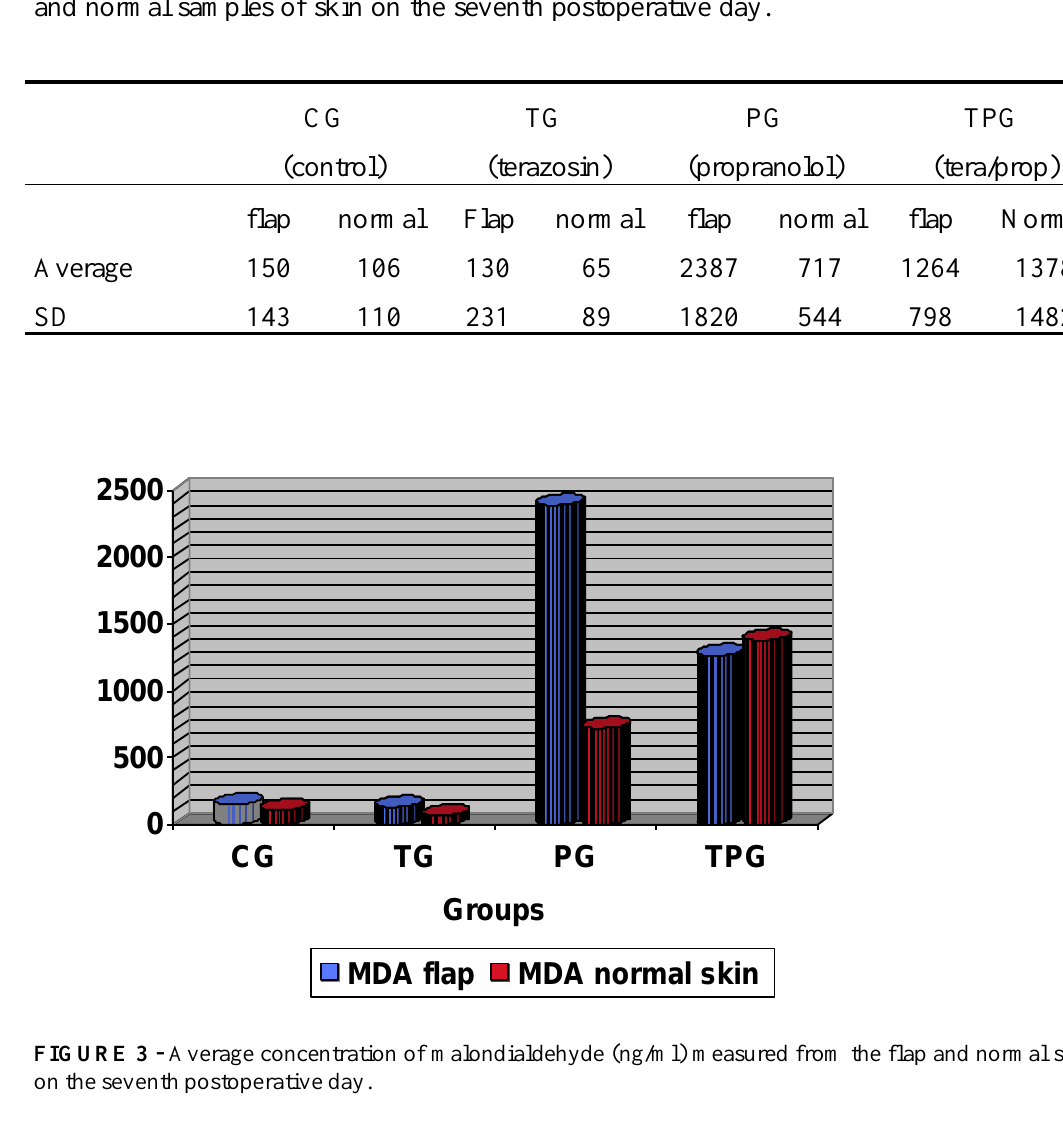
TABLE 3 - Average concentration of malondialdehyde (ng/ml) measured from the flap and normal samples of skin on the seventh postoperative day.